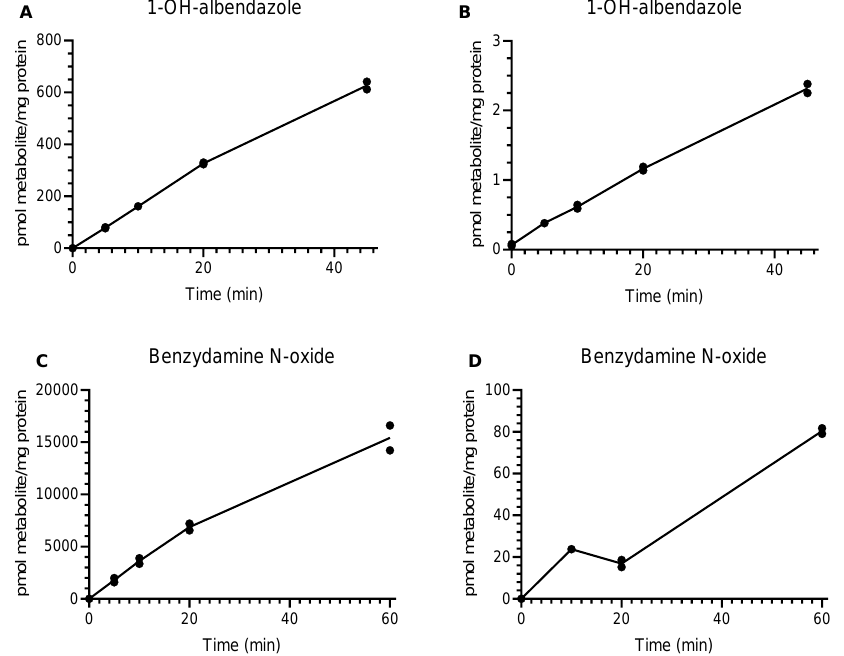
Figure 1. Rate of metabolite formation after incubation of drug-metabolizing enzyme substrates with rat ( A , C ) and human ( B , D ) lung microsomes: ( A , B ) CYP2J2-dependent 1-OH-albendazole; ( C , D ) FMO-dependent benzydamine N-oxide.